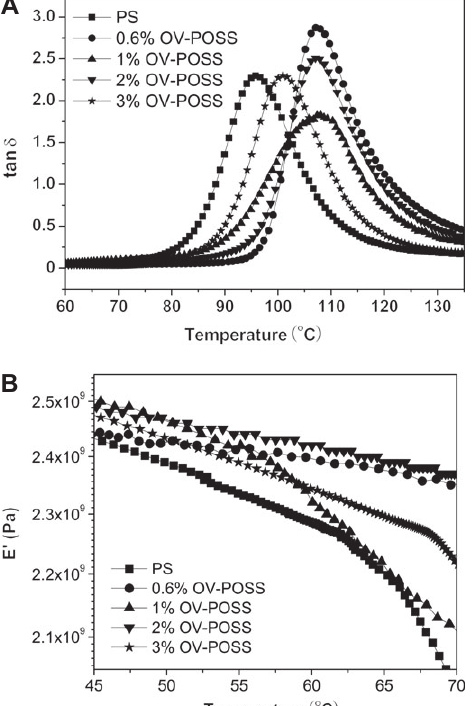
Figure 5 DMA traces that show loss tangents tan δ (A) and tensile storage moduli E ′ (B) as a function of